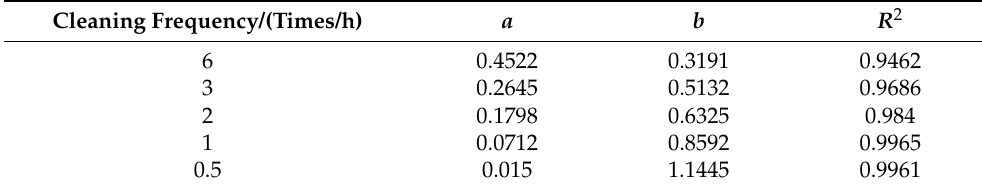
Table 3. a , b , and R 2 under different cleaning frequencies. Cleaning